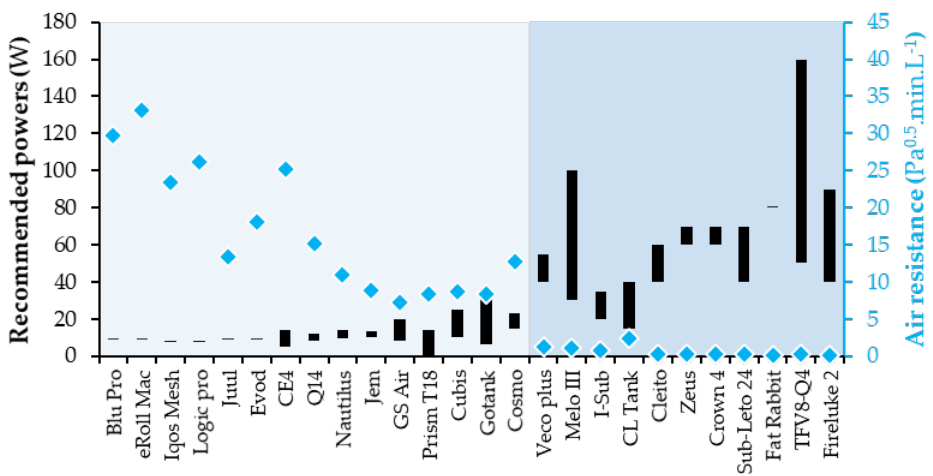
Figure 13. Recommended powers of the twenty-six tested devices regarding their air resistances (extracted from the pressured drop measurements).